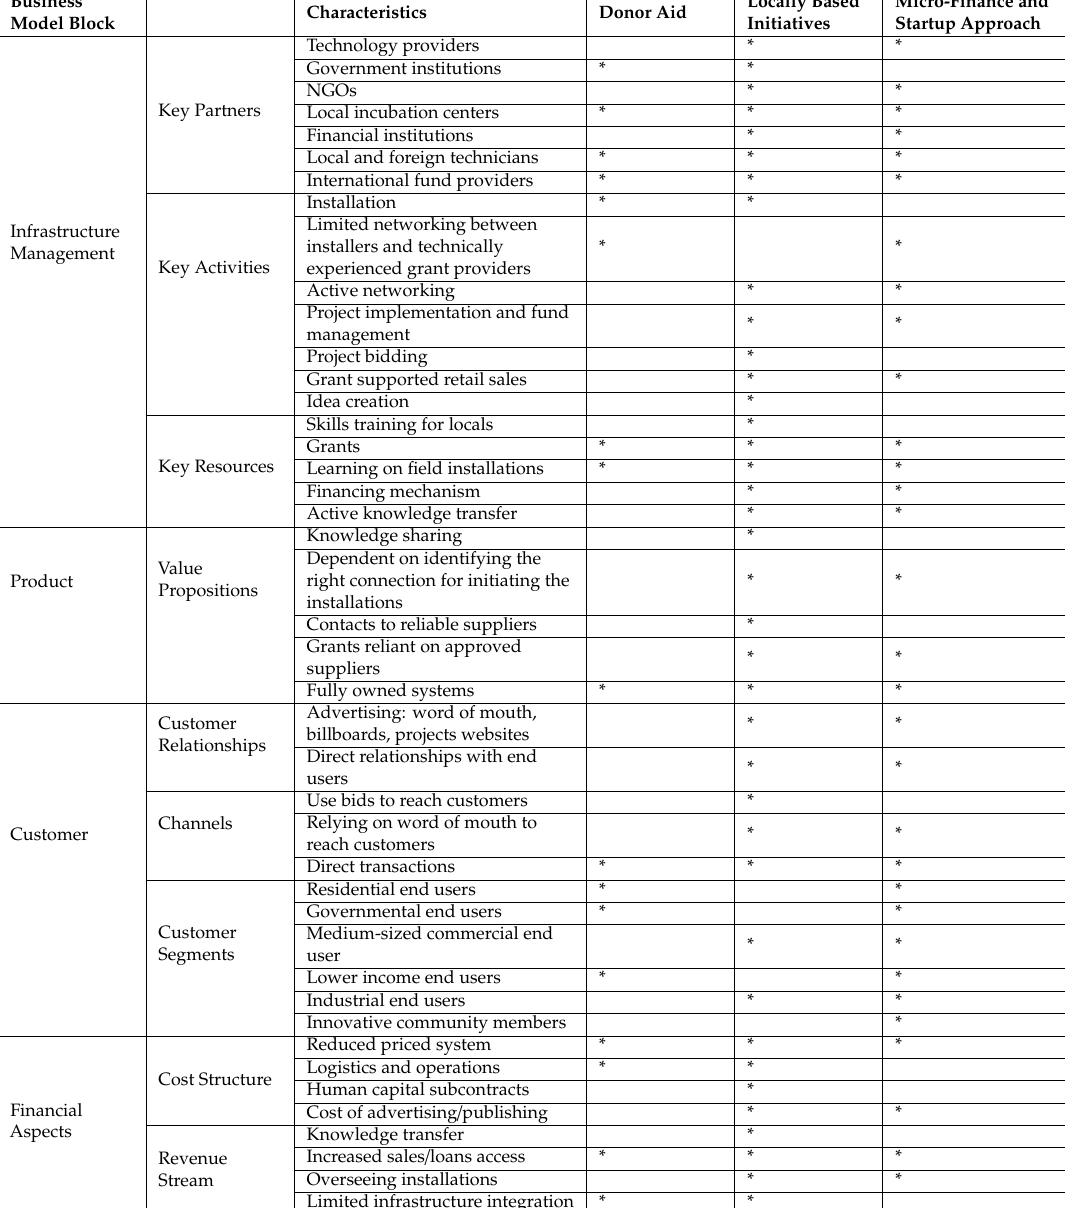
Table 2. Characteristics of business models used in the Lebanese solar energy niche